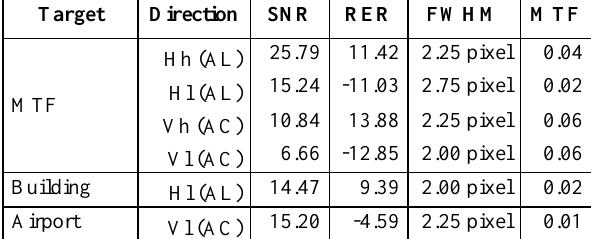
Table 2. SNR, RER, and FWHM results obtained from the MTF and the natural targets the four directions.